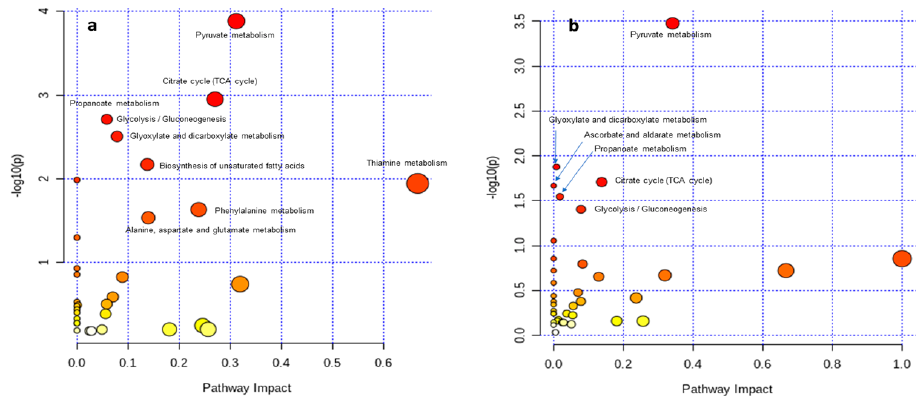
Figure 6. Metabolome view map of the differential metabolites (variable importance projection > 1, p < 0.05) identified in the feces of sows fed different acid detergent fiber levels (( a ): 4.3% vs. 6.5%; ( b ): 5.4% vs. 6.5%) during late gestation. The x-axis represents the pathway impact and the y-axis represents the pathway enrichment. The node color is based on its p -value, and the node radius is determined based on the pathway impact values. Larger sizes and darker colors represent higher pathway enrichment and impact values, respectively.